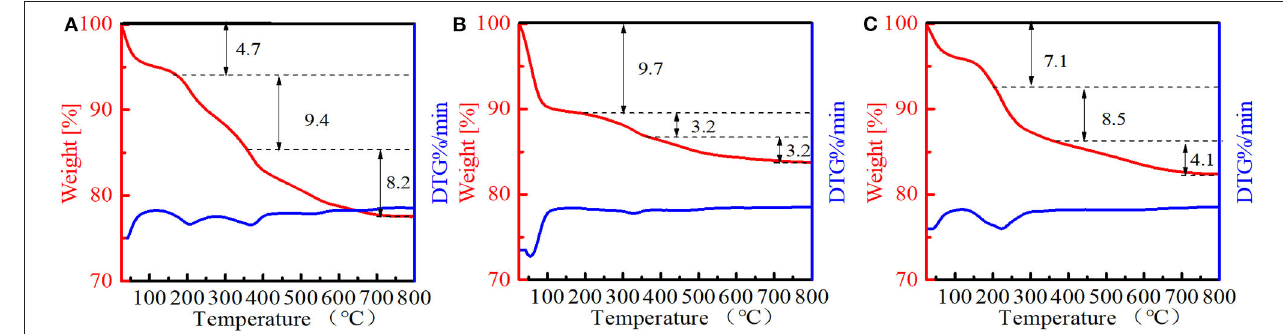
FIGURE 4 | TGA analysis of Ti-MWW-AM (A) , Ti-MWW-AT (B) , and R-Ti-MWW-PI (C) .